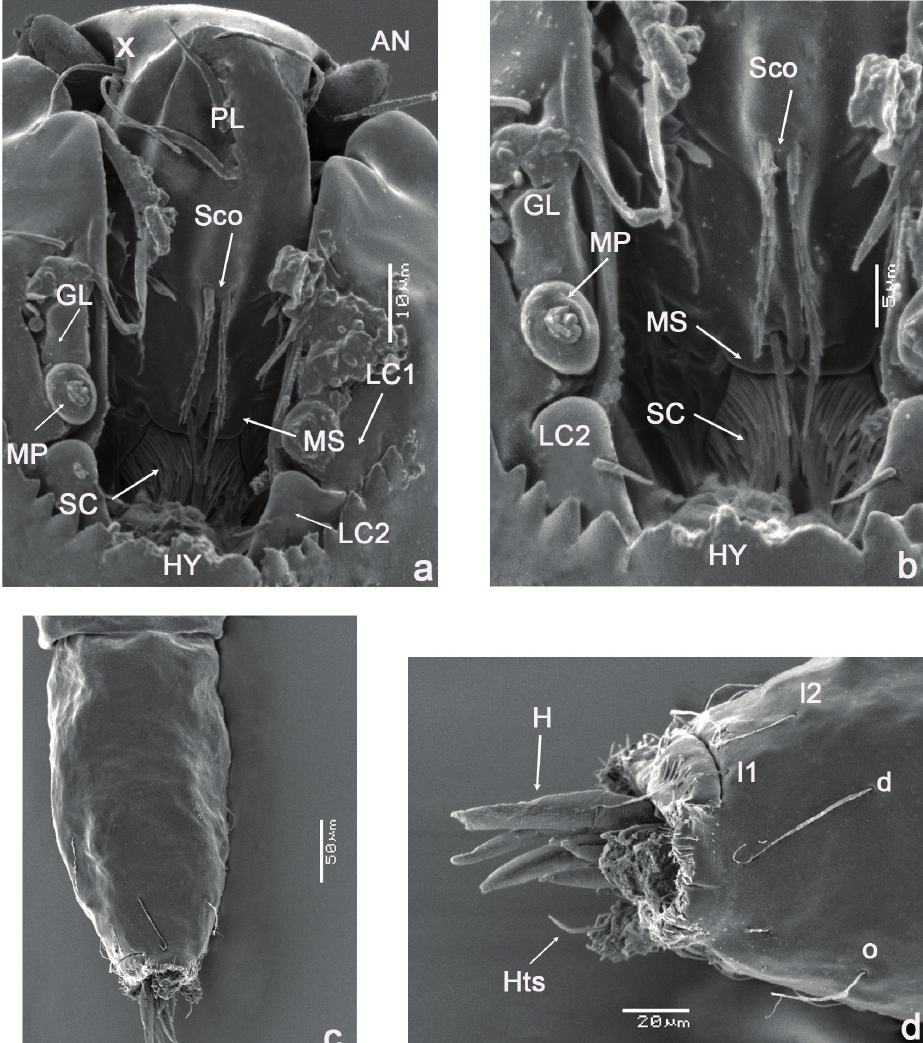
Figure 2 - Dasyhelea flavifrons Guérin-Méneville, larva (SEM). a ) detail of palatum (frontal view); b ) detail maxilla, messors and scopae (frontal view); c ) caudal segment (lateral view); d ) detail of caudal segment (lateral view). Antenna (AN); galeolacinia (GL); hooks (H); hooklets (Hts); hypostoma (HY); lacinial sclerite 1 (lC1); lacinial sclerite 2 (lC2); maxilla (MX); maxillary palpus (MP); messors (MS); palatum (Pl); sensilla campaniformia (Sca); sensilla coeloconica (Sco), scopae (SC). Caudal segment chaetotaxy: d, dorsal setae; l first lateral setae; l , second lateral setae; o, outer setae. 1 2 REDESCRIPTION OF THE FEMALE PUPA (FIGS. 4-5) (N=3) Color in life brownish. exuviae general coloration pale brown. Total length 2.52 mm. Head : Dorsal apotome (Fig. 4a) 2.04 X times as wide as long, apex rounded, surface covered with small rounded tubercles, anterior margin nearly straight, with